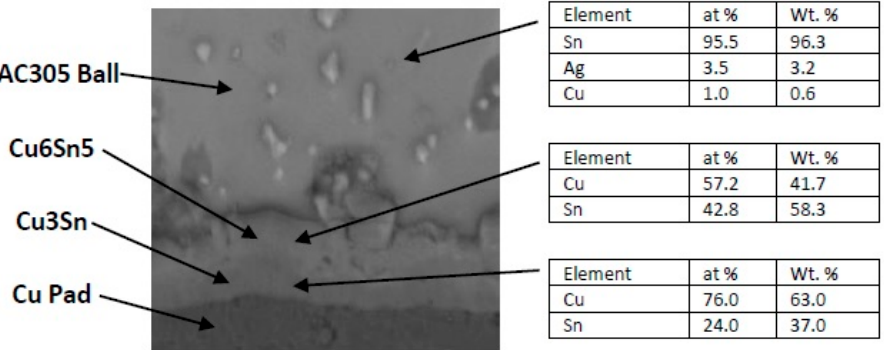
Figure 9. Microstructure of SAC305 fused to a copper pad and then thermally aged at 150 °C for 1000 h.